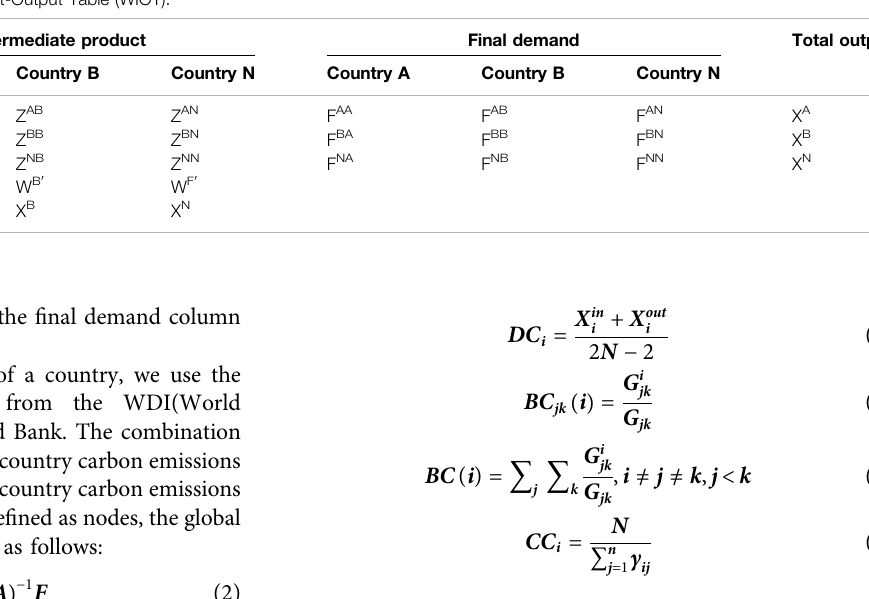
TABLE 1 | The basic structure of the World Input-Output Table